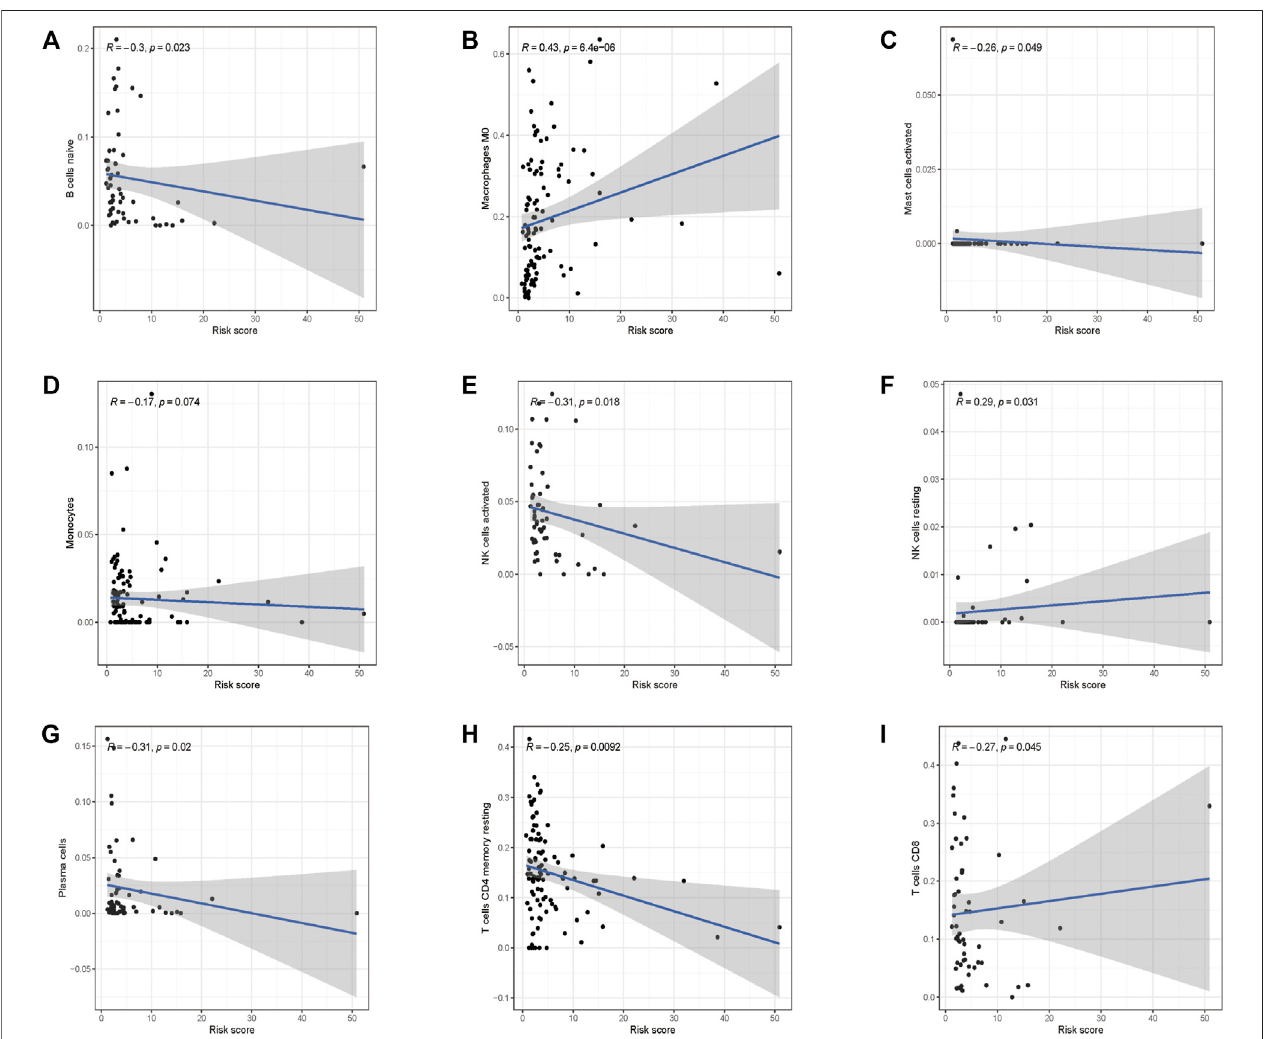
FIGURE 9 | Correlations between the prognostic risk score and immune cell in fi ltration. (A) B cells, (B) M0 macrophages, (C) activated mast cells, (D) monocyte cells, (E) activated NK cells, (F) resting NK cells, (G) plasma cells, (H) resting CD4 + cells, and (I) CD8 + cells.